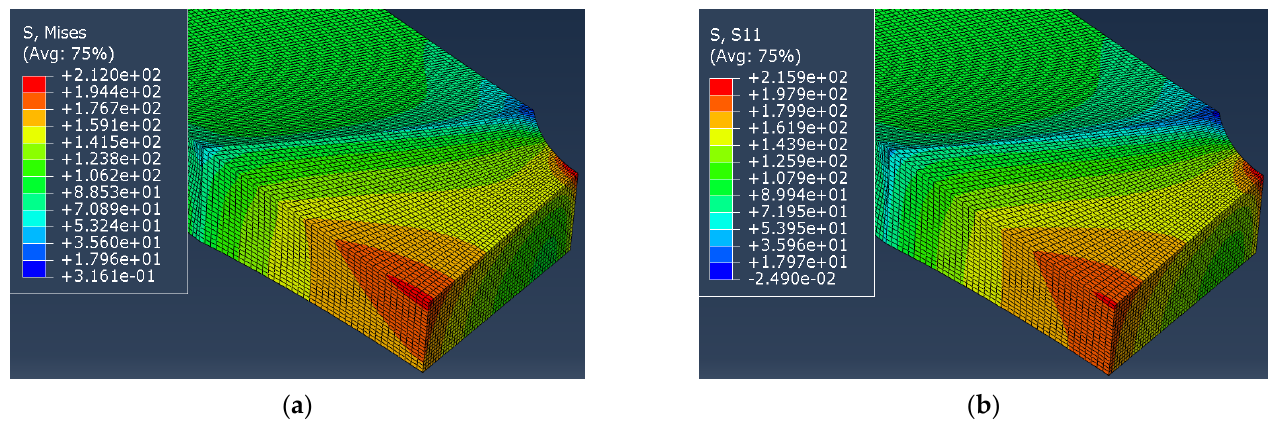
Figure 7. Stress distribution in specimen C1-1 with deformed weld metal: ( a ) equivalent stresses, ( b ) normal stresses, given in MPa.